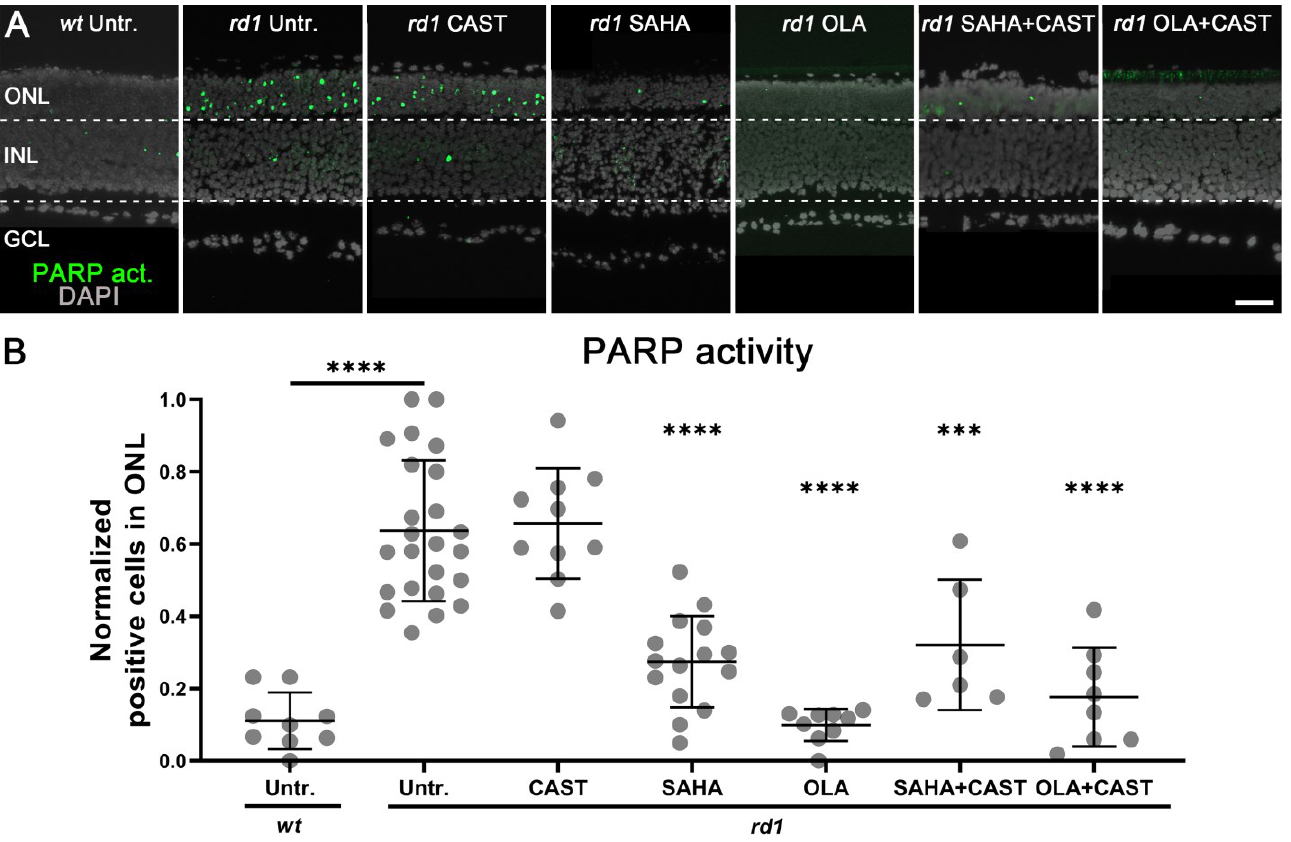
Figure 4. Effects of mono- and combination therapies on photoreceptor PARP activity. ( A ) Retinal PARP activity was assessed using an in situ activity assay (green). DAPI was used as nuclear coun- terstain (grey). In the outer nuclear layer (ONL) of the untreated (Untr.) rd1 retina, PARP activity was strongly increased compared to the wild-type ( wt ). ( B ) Quantification of the numbers of PARP activity-positive cells in the various experimental groups. While the calpain inhibitor CAST had no effect on PARP activity, it was significantly reduced by both the HDAC inhibitor SAHA and the PARP inhibitor. Combined treatment with SAHA and CAST or OLA and CAST reduced PARP activity to levels comparable to monotherapy. Images shown represent at least six different specimens for each genotype. Untr. wt : 9 explants from 9 different mice; untr. rd1 : 20/20; CAST rd1 : 10/10; SAHA rd1 : 15/15; OLA rd1 : 9/9; SAHA + CAST rd1 : 6/6; OLA + CAST rd1 : 8/8; error bars represent SD; INL = inner nuclear layer; GCL = ganglion cell layer. Scale bar = 50 µ m; significance levels: ***, p < 0.001; ****, p <